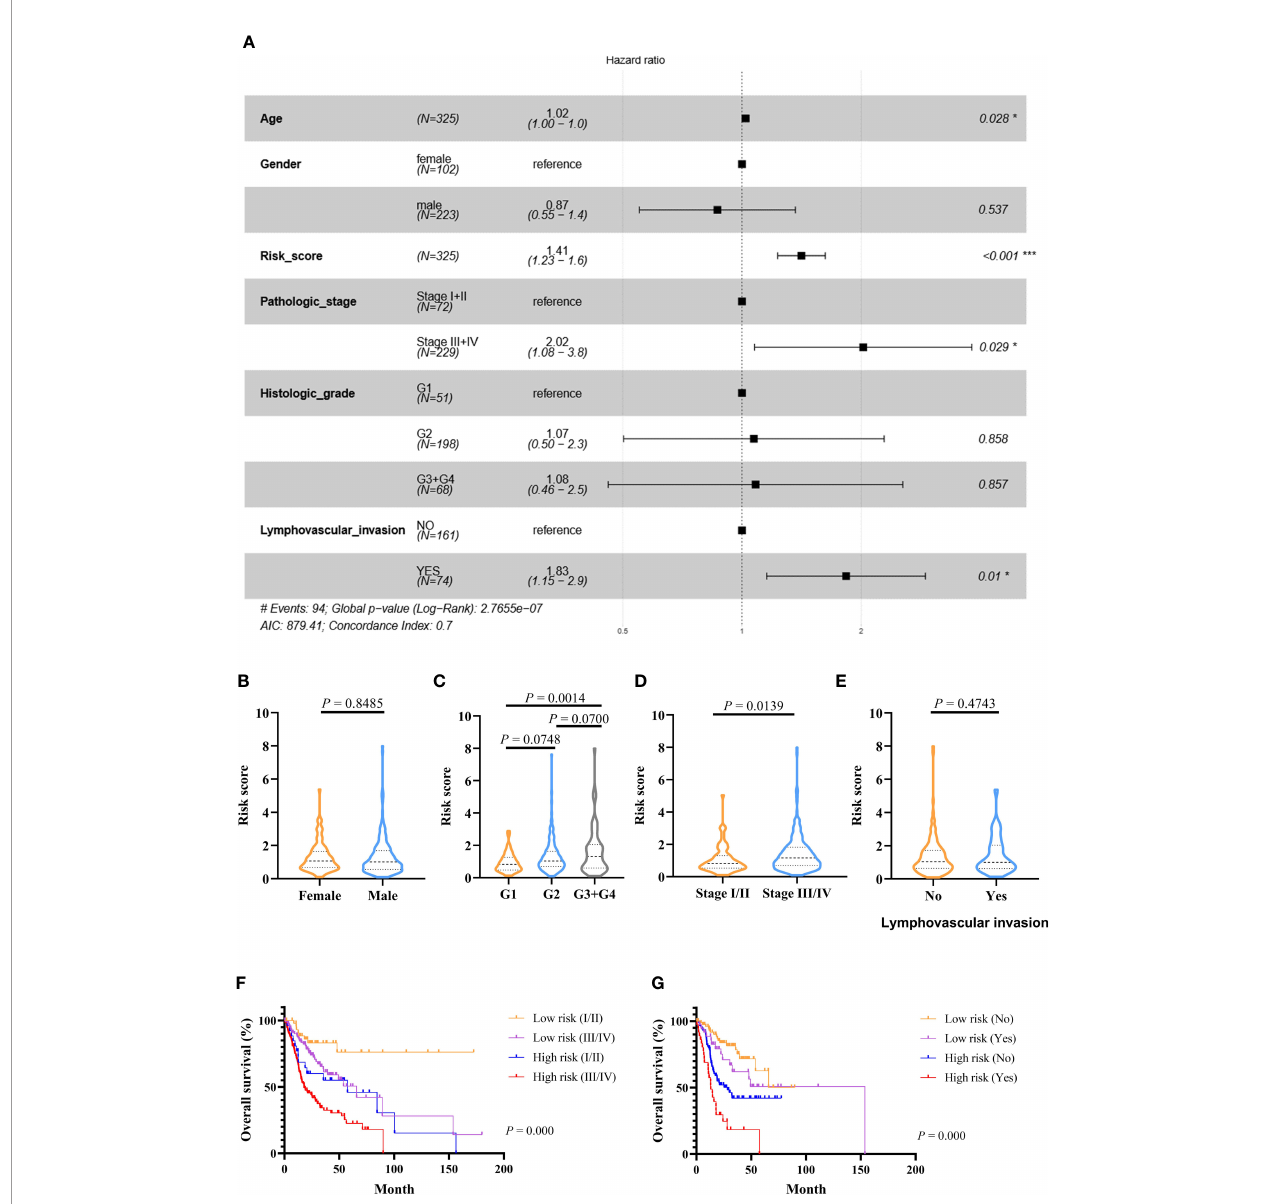
FIGURE 4 | Prognostic values of the immune-related signature model in the TCGA cohort. (A) Multivariate Cox regression analysis regarding OS in OSCC. (B – E) The distribution of risk scores in OSCC samples strati fi ed by gender, histologic stage, pathologic stage, and lymphovascular invasion. (F) Kaplan – Meier curves for patients strati fi ed by both pathologic stage and risk scores. (G) Kaplan – Meier curves for patients strati fi ed by both lymphovascular invasion and risk scores. p < 0.05 shows signi fi cant difference. Survival signi fi cance calculated using Cox regression analysis. # just indicates the Events number. * p value < 0.05, ** p value < 0.01, *** p value <